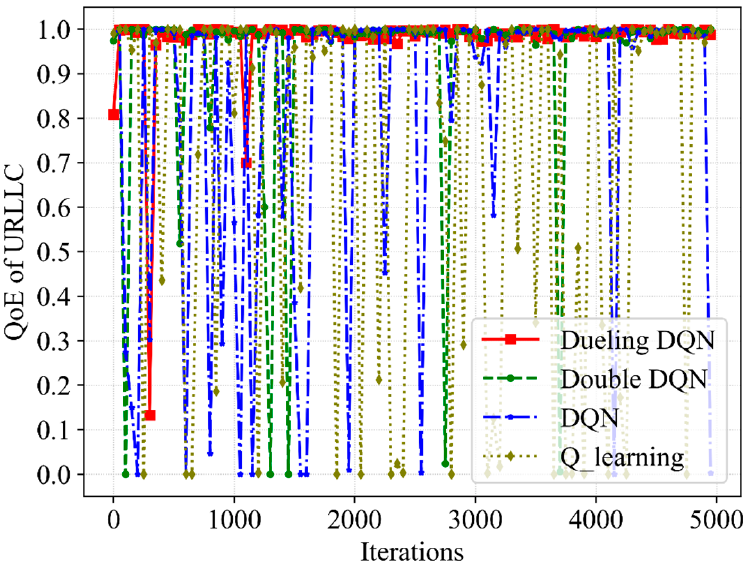
Figure 4. A comparative result of QoE for URLLC service with different slicing algorithms.